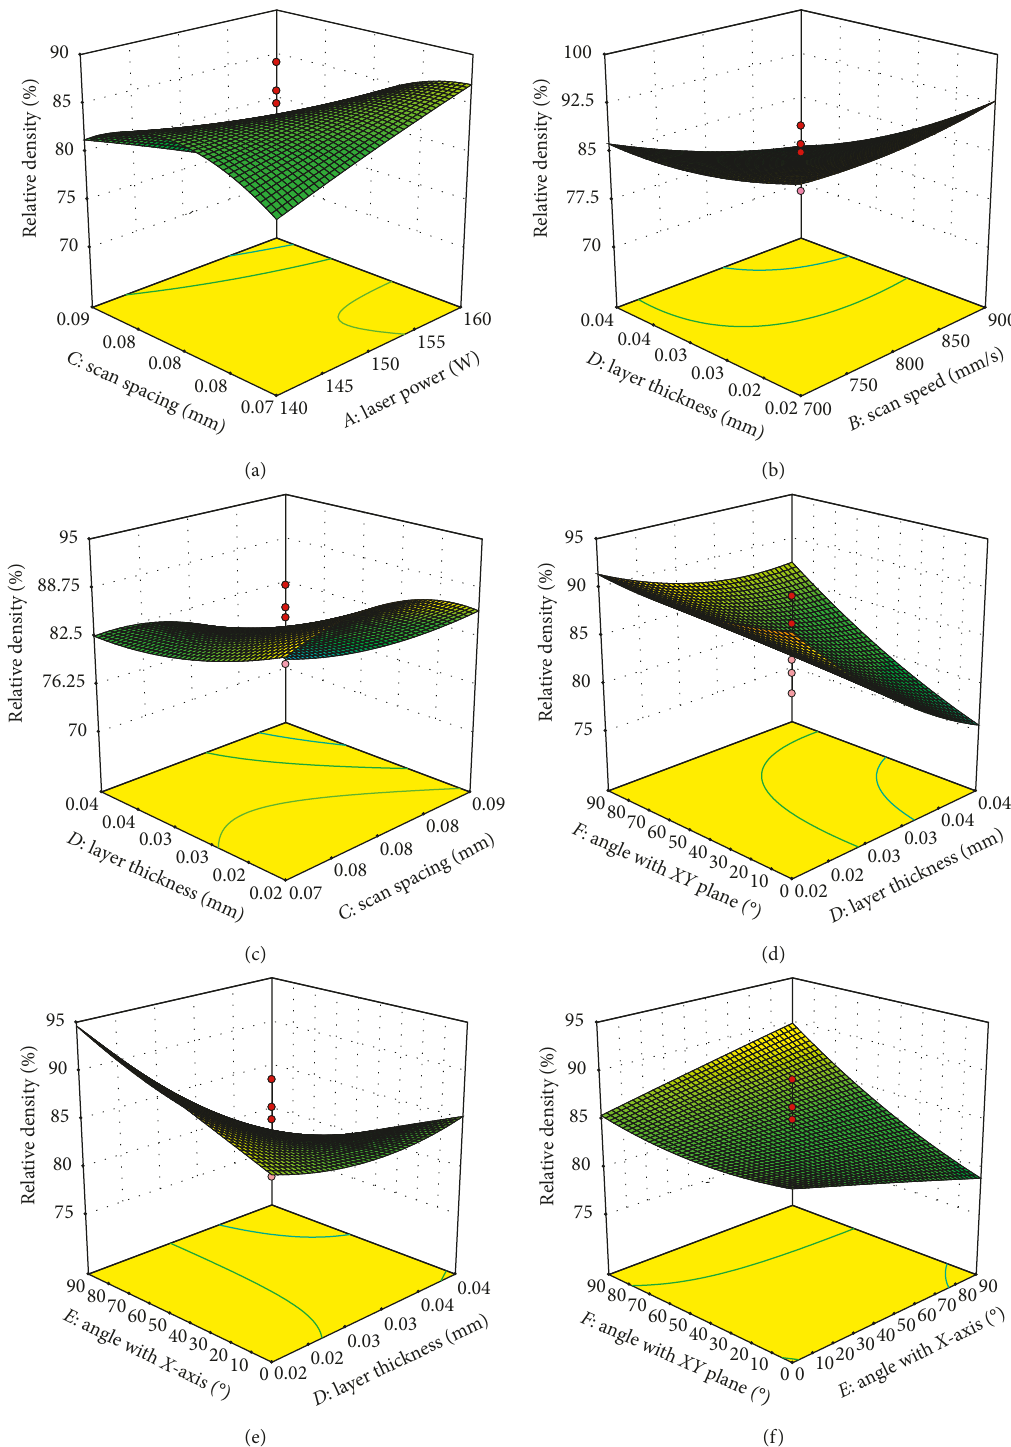
Figure 7: Effect of laser power, scan speed, scan spacing, layer thickness, angle with the xz plane, and angle with the xy plane on density. (a) Effect of interaction of laser power and scan spacing on density. (b) Effect of interaction of scan speed and layer thickness on density. (c) Effect of interaction of scan spacing and layer thickness on density. (d) Effect of interaction of angle with the xy plane and layer thickness on density. (e) Effect of interaction of angle with the xz plane and layer thickness on density. (f) Effect of interaction of angle with the xy plane and angle with the xz plane on